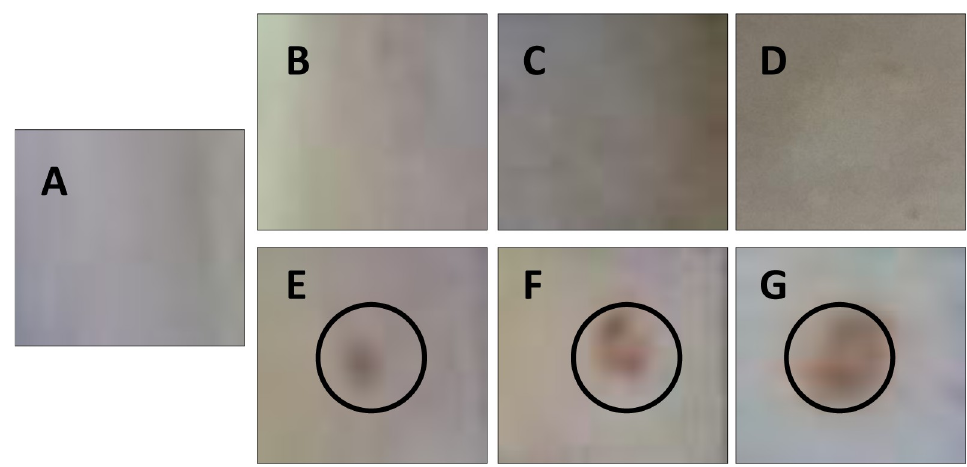
Fig 1. Dosimetry studies of rat skin exposed to 532 nm laser. Fig 1A represent unexposed rat skin while Fig 1B–1F presents shows rat skin exposed to 532 nm laser at various fluences; 0.1 W/cm 2 (B), 0.25 W/cm 2 (C), 0.5 W/cm 2 (D), 1.0 W/cm 2 (E), 1.5 W/cm 2 (F) and 2.0 W/cm 2